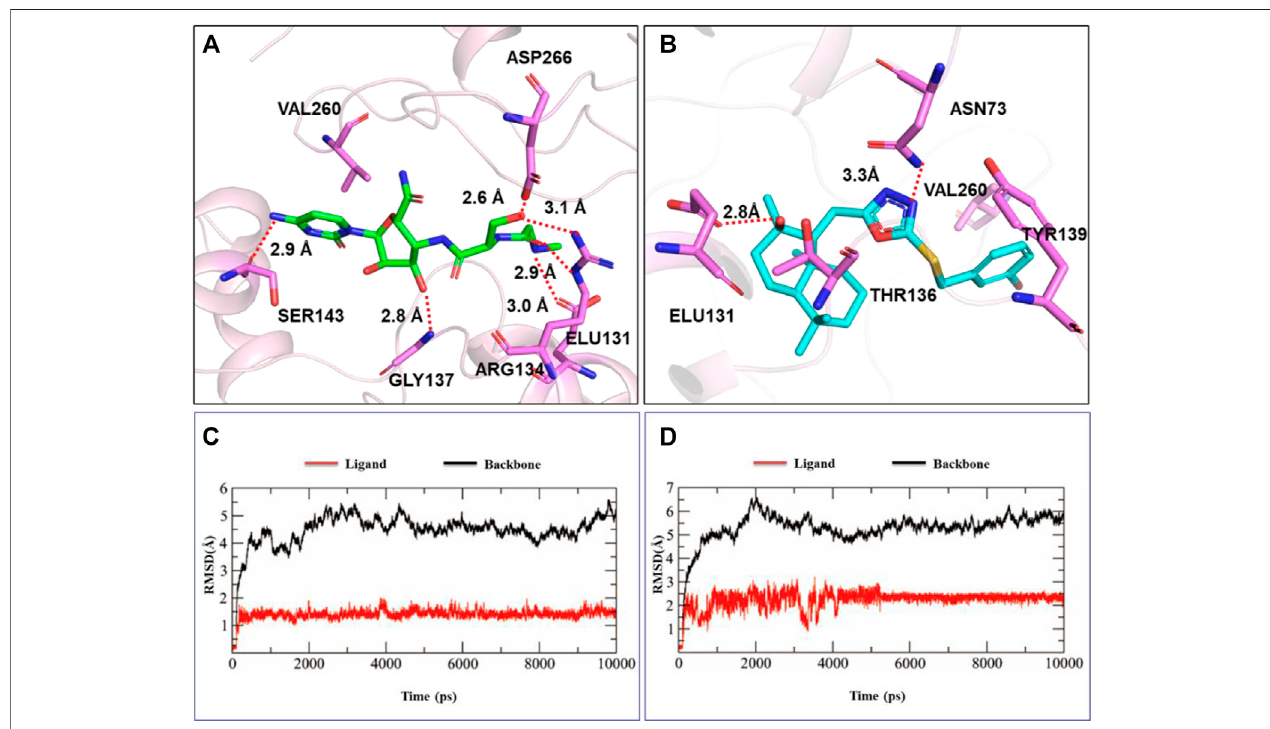
FIGURE 3 | Molecule docking and MD simulation studies: (A) molecule docking of ningnanmycin, (B) molecule docking of compound H10 , (C) MD simulation of ningnanmycin, (D) MD simulation of compound H10 .